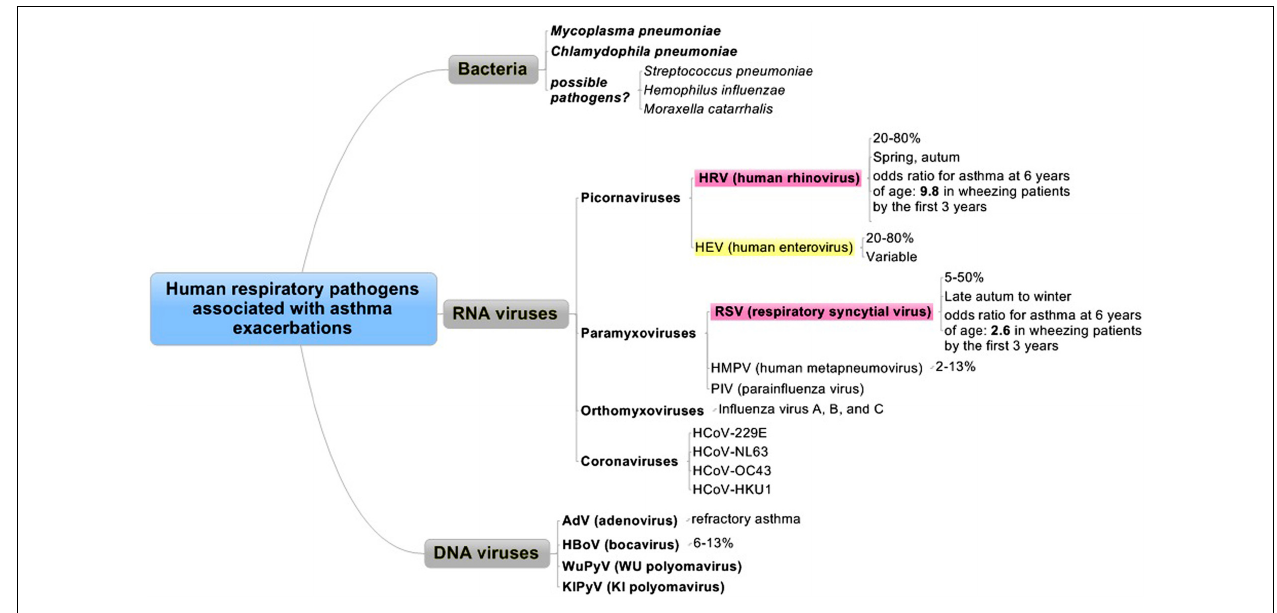
FIGURE 1 | Human respiratory pathogens associated with asthma exacerbations. Pathogens are divided into three categories as bacteria, RNA viruses, or DNA viruses. Red and yellow columns are the most relevant pathogens in order.